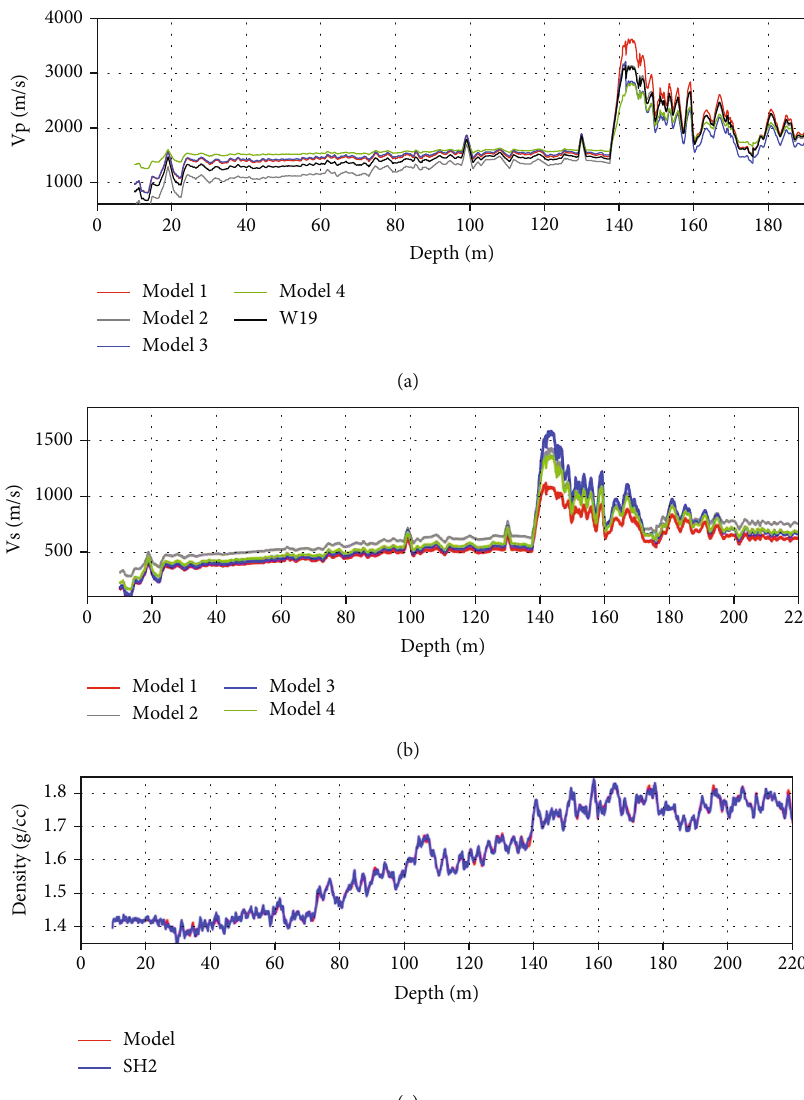
Figure 13: Comparison of V and V at well W19 based on di ff erent models (original boreholes): (a) V p s di ff erent models, and (c) density of Model and SH2. Model 1 is a pore- fi lling model, Model 2 is a thermodynamic elastic model, Model 3 is a particle cementation model, SH2 is a measured drilling curve, and Model 4 is a modi fi ed model; data 1 is a measured drilling curve, and data 2 is the estimated